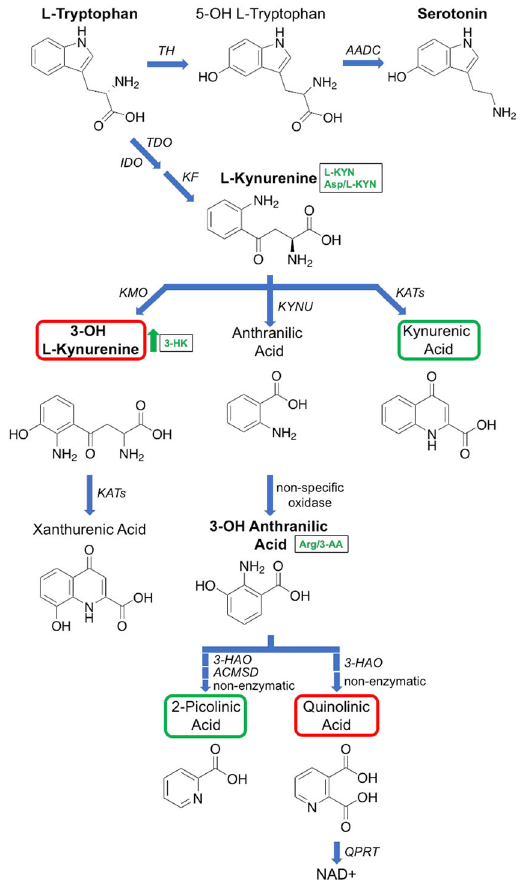
Fig. 4 Tryptophan/kynurenine pathway. The main end product of this pathway is NAD + (nicotinamide adenine dinucleotide). Trp can also be converted to serotonin. The metabolites highlighted in bold have been targeted and detected in this study. Metabolites surrounded by red boxes are neurotoxic and by green boxes are neuroprotective. L -Kynurenine, 3-OH L -Kynurenine and 3-OH anthra- nilic acid are all signi fi cantly changed in the iPD cohort (arrow and text written in green). IDO indoleamine 2,3-dioxygenase), TDO tryptophan 2,3-dioxygenase), KF kynurenine formamidase, KMO kynurenine 3-monooxygenase, KYNU kynureninase, KAT kynurenine aminotransferase, 3-HAO 3-hydroxyanthranilic acid dioxygenase, ACMSD 2-amino-3-carboxymuconate-6-semialdehyde decarboxy- lase, QPRT nicotinate-nucleotide pyrophosphorylase, TH tryptophan hydroxylase and AADC aromatic amino acid